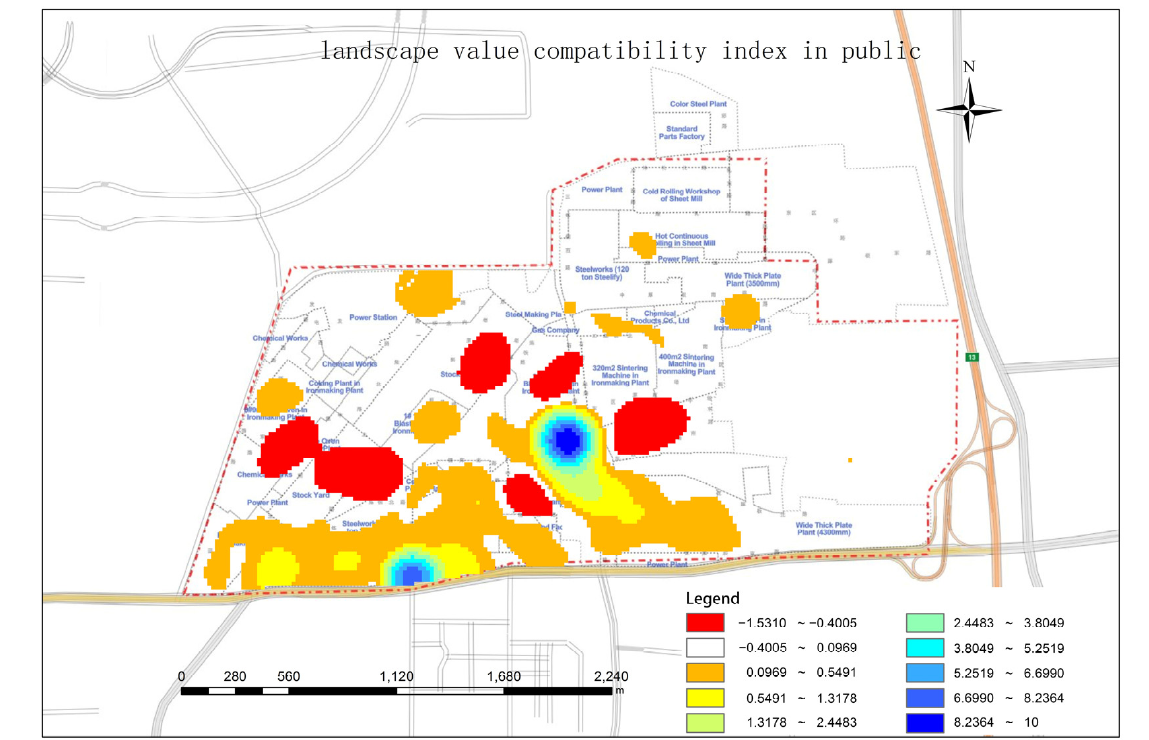
Figure 5. Landscape value compatibility index in public space redevelopment.